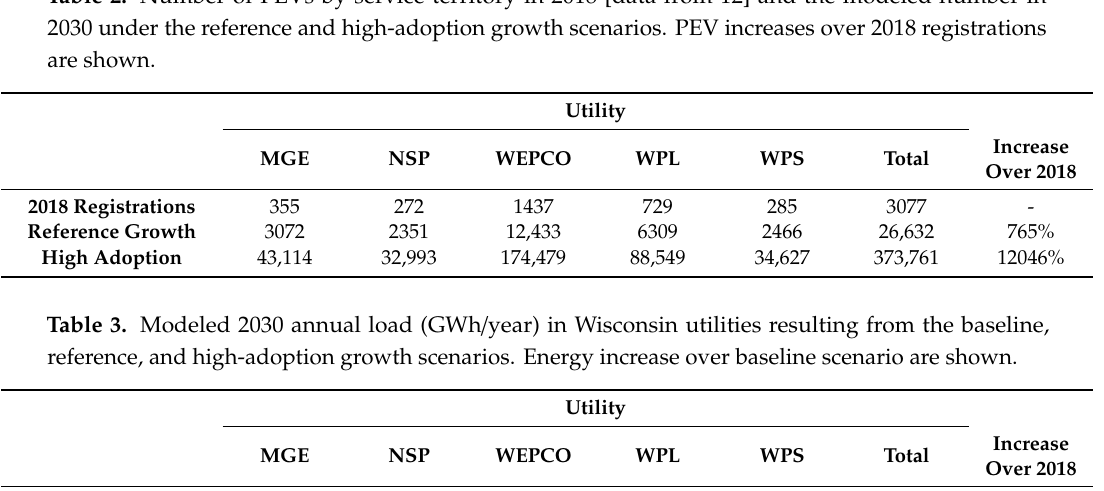
Table 2. Number of PEVs by service territory in 2018 [data from 12] and the modeled number in 2030 under the reference and high-adoption growth scenarios. PEV increases over 2018 registrations are shown.